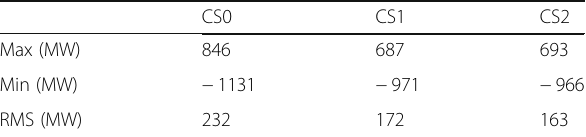
Table 4 The quality of ACE in area